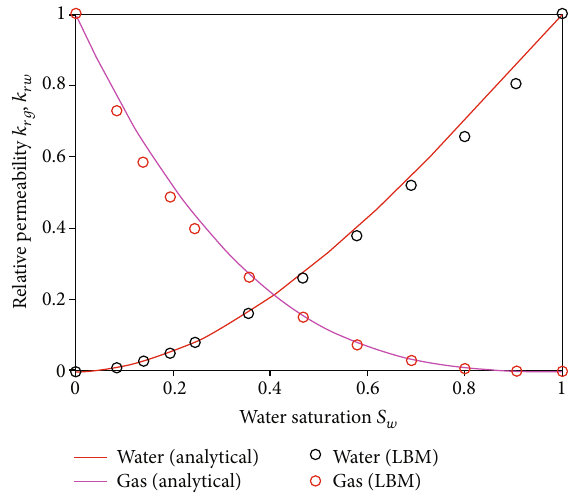
Figure 7: Comparison between LBM simulation results and analytical solution for gas and water relative permeability, M = 0 : 010